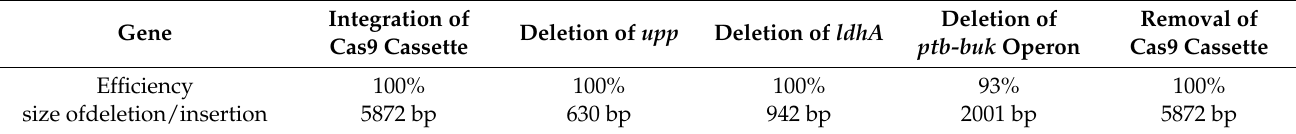
Table 3. Summarizing the efficiency of genetic modifications performed using the CRISPR/Cas9 system. Integration Gene